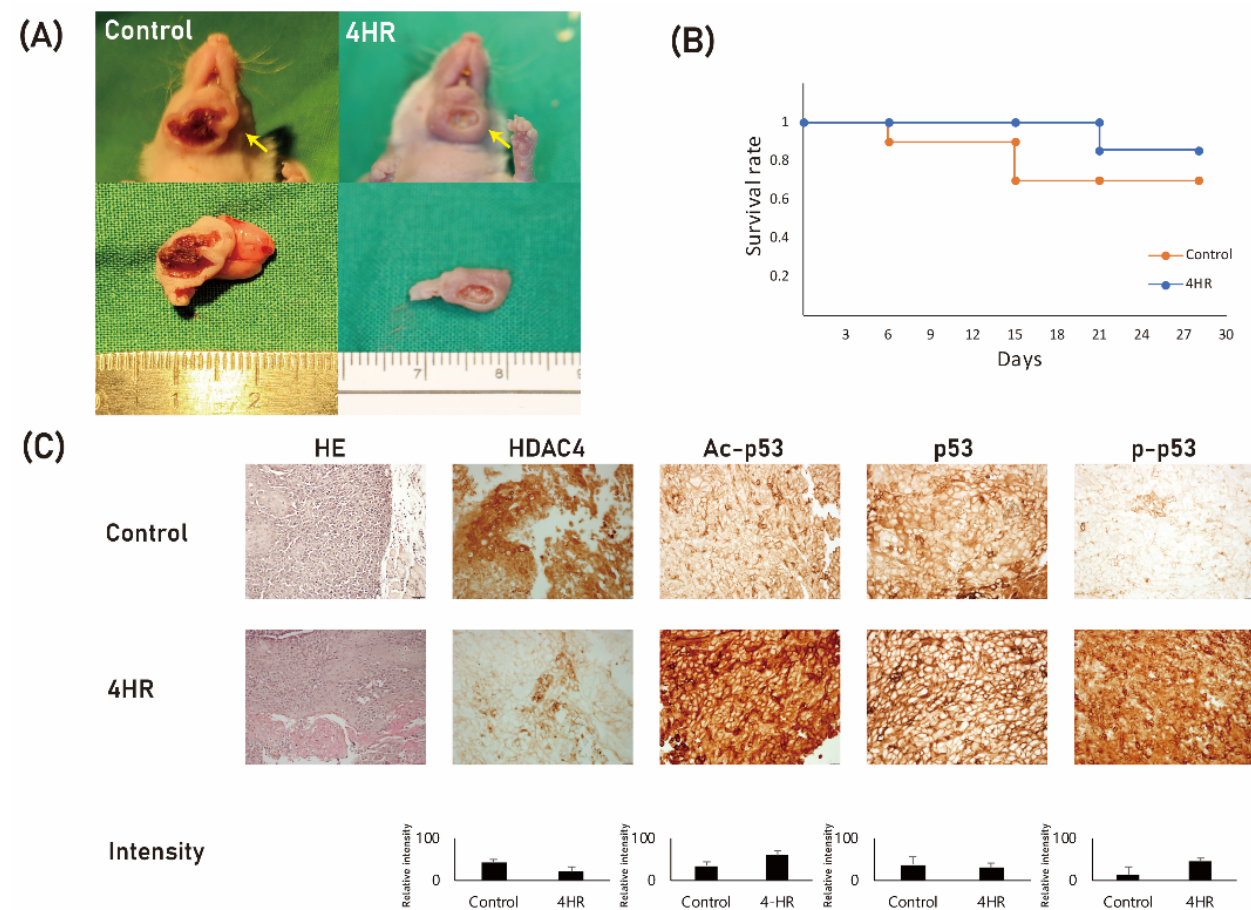
Figure 6. The result of xenograft study. ( A ) YD-15 cells were injected into the sublingual space. As the tumour grew, skin ulceration was observed in both groups. ( B ) Survival curve. The survival rate of the 4HR group was higher than that of the control group. However, the differences were not statistically significant. ( C ) Histological finding. The average intensity of each protein was in accordance with the results of the in vitro experiment. However, there was no significant difference due to small sample number.